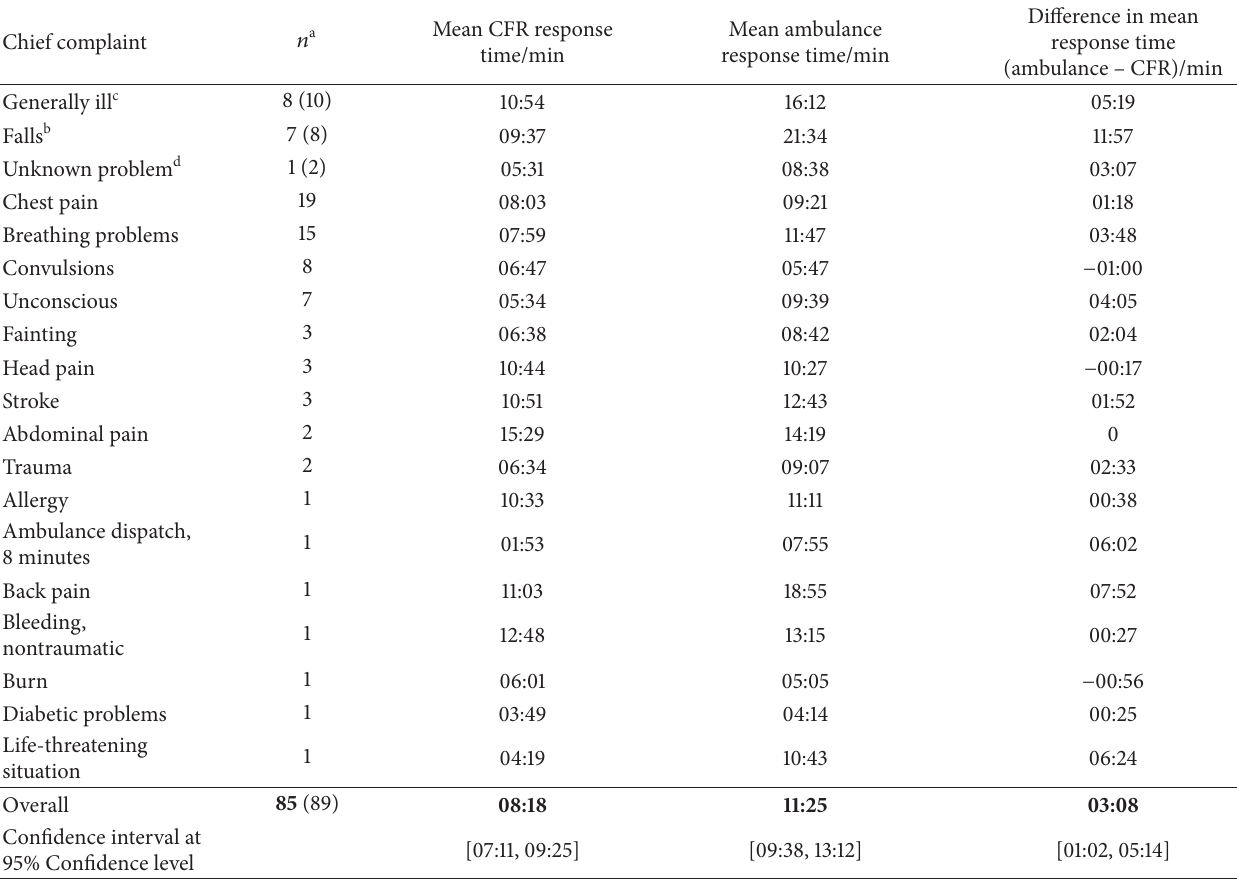
Table 1: Mean response times of CFR and ambulance crews by chief complaint, showing a statistically significant (at the 95% confidence level) mean decrease of 3 minutes and 8 seconds, comparing ambulance response times to CFR response times.